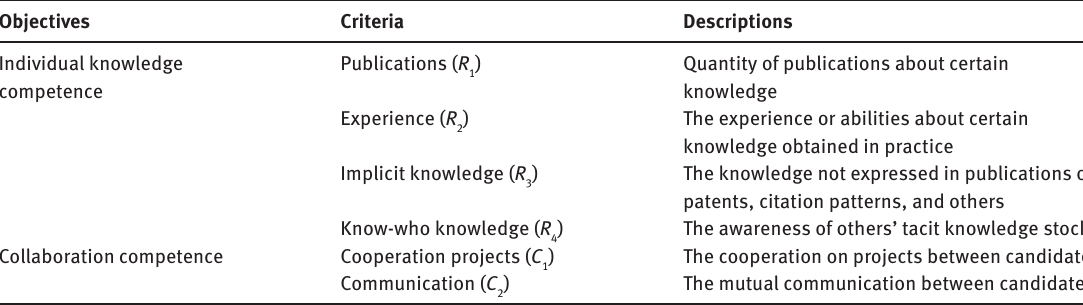
Table 1: Criteria for Member Selection of the Research and Development Team.